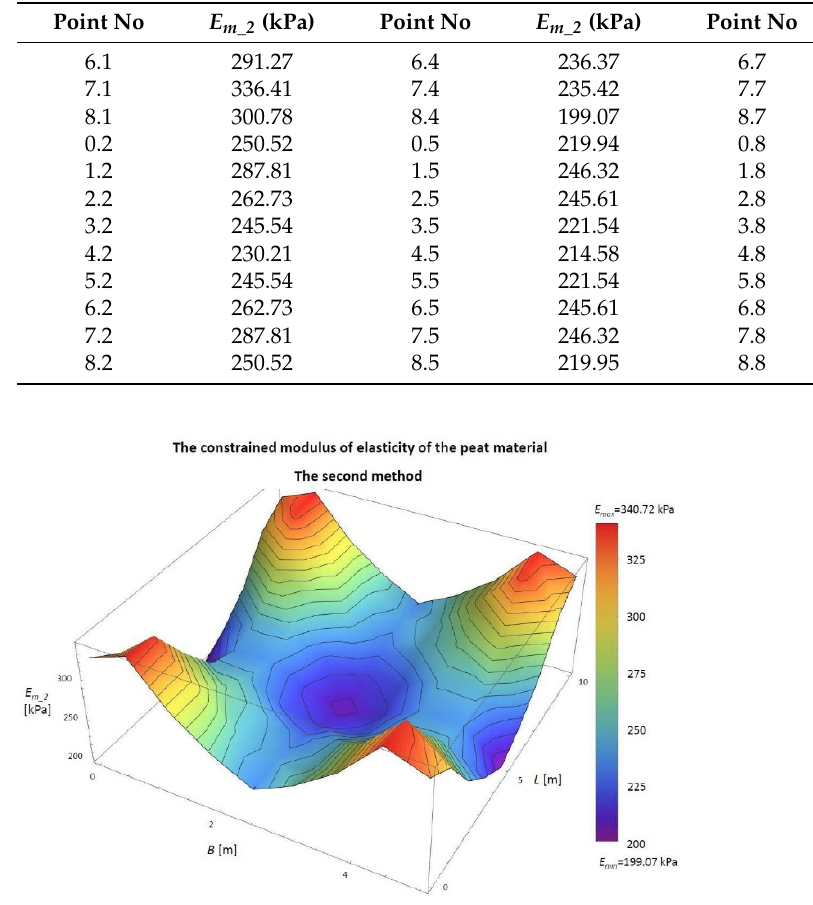
Figure 13. The values of the J i parameter in the 3D view for the numerical simulation. The constrained modulus of elasticity of peat material determined by the second model ( E m_2 ) in the 3D view. B , width of the embankment (m); L , length of the embankment (m).